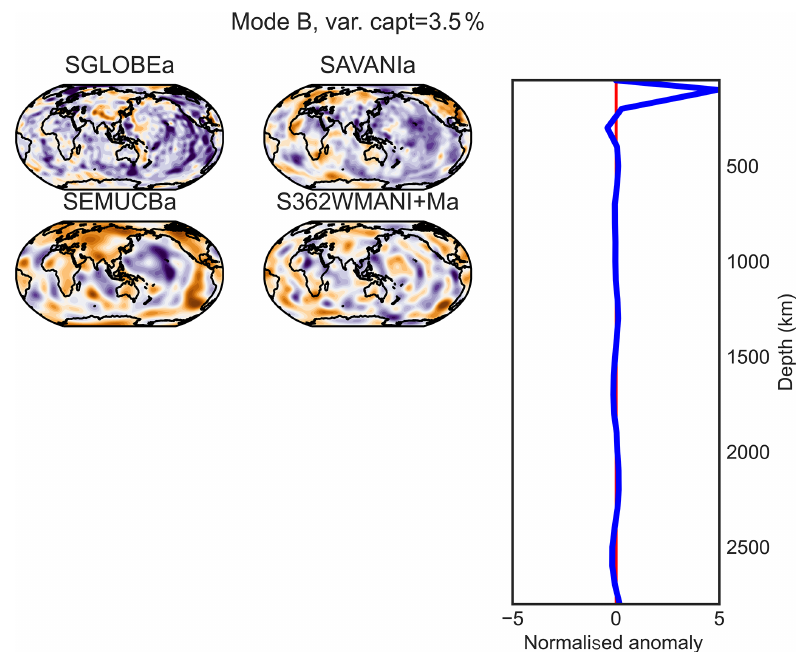
Figure E2. PC B (maximum at 100km of depth) of the combined analysis of the anisotropic parts of the models.